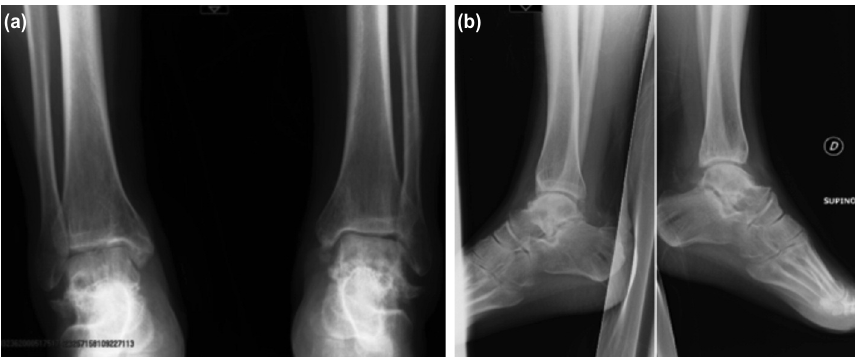
(a), (b) At 18 months of FU, radiograph after removal of the screws. Radiograph shows a severe bilateral talonavicular arthrosis Fig. 3: and moderate arthrosis of the sub-talus joint. The patient was satisfied with his quality of life and he returned to fly with his